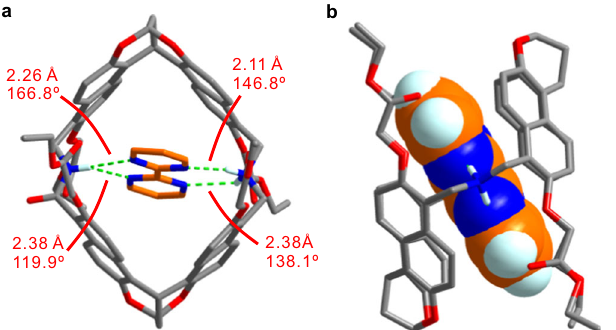
Fig. 4 X-ray single crystal structure of G4@4b ∙ H + . a The over view of G4 @ 4b ∙ H + is presented as a stick model, showing four hydrogen bonds between guest and host. b Host and guest are shown with stick model and space- fi lling model in the side view of G4 @ 4b ∙ H + , respectively. G4 is fully encapsulated in the cavity of 4b (cid:129) H + . Most of hydrogen atoms and PF 6 − counter ions are omitted for viewing clarity. Color codes: carbon, gray or orange; oxygen, red; nitrogen, blue.